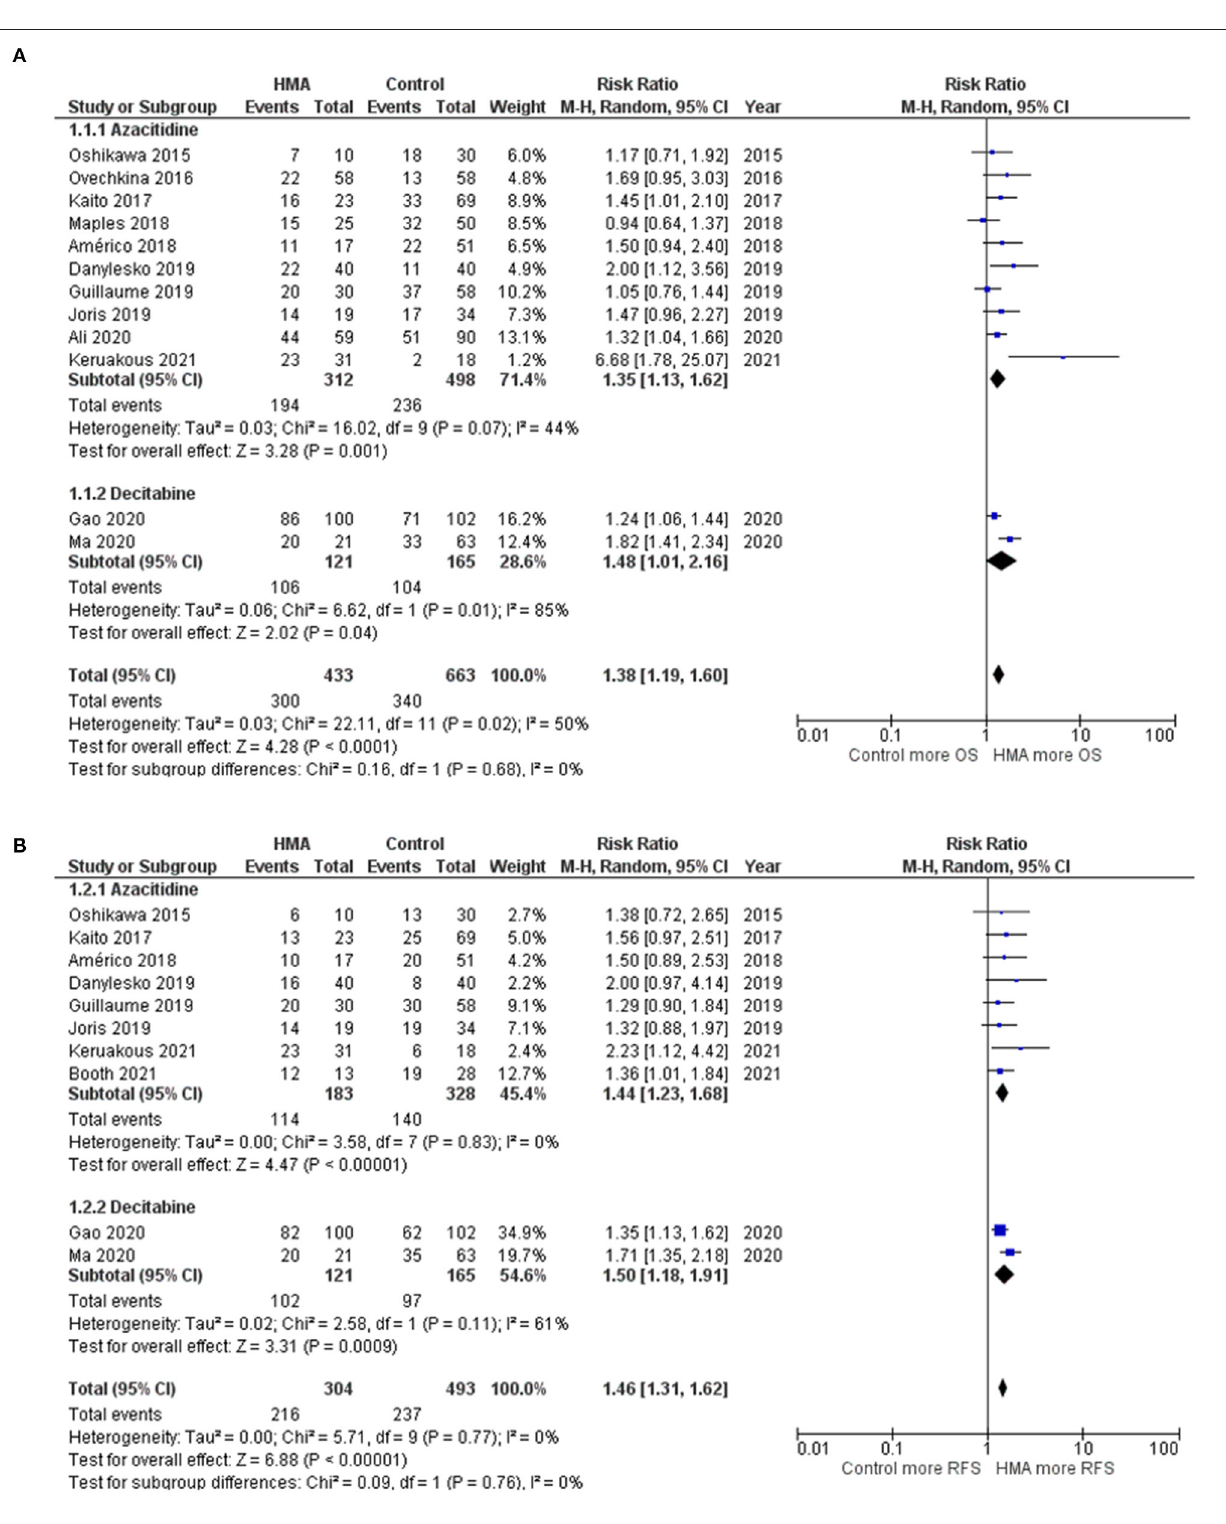
Frontiers in Medicine |